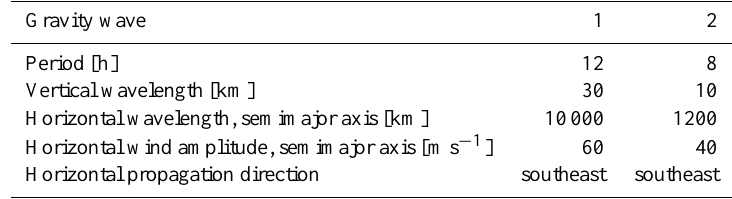
Table 2. Approximate gravity wave parameters from hodograph analysis of wind components.